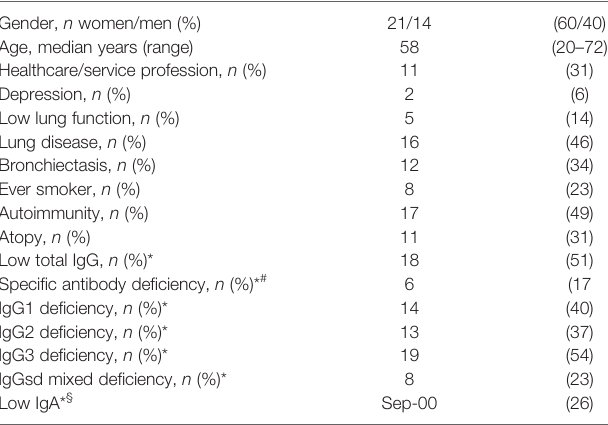
*WithoutIgreplacementtherapy, # de fi ciencyofpneumococcalantibodiesandhaemophilus in fl uenzae serotype B antibodies, § none of the participants had IgA<0.07